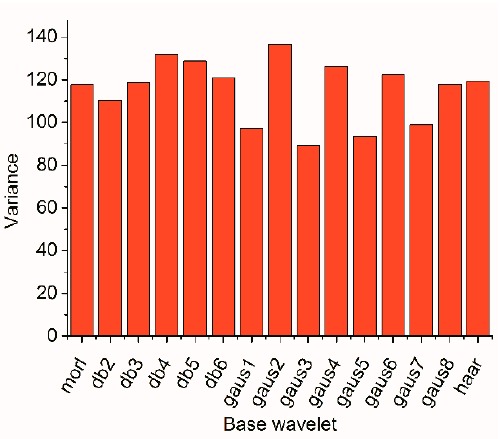
Figure 6. The variance value for all candidate mother wavelets in the repository by the adaptive wavelet selection procedure.